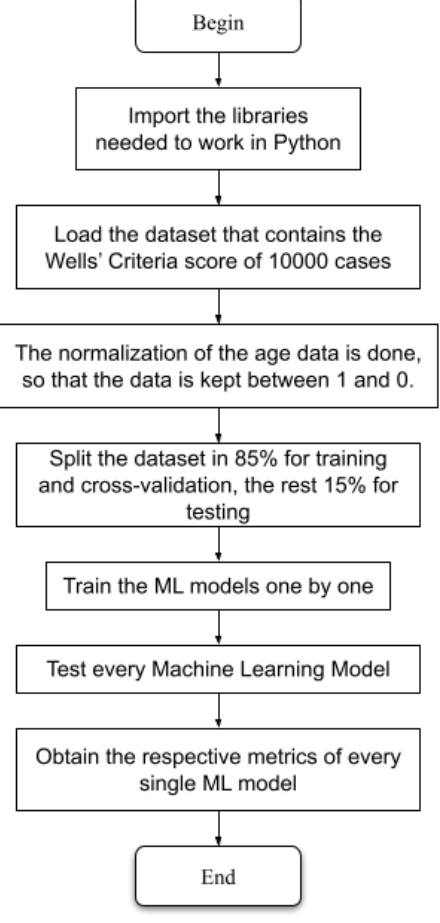
Figure 1. Proposed methodology for early diagnosis of